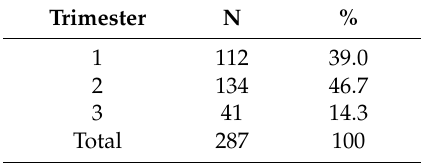
Table 2. Study population by trimesters of pregnancy; Apulia, Southern Italy 2017–2019.